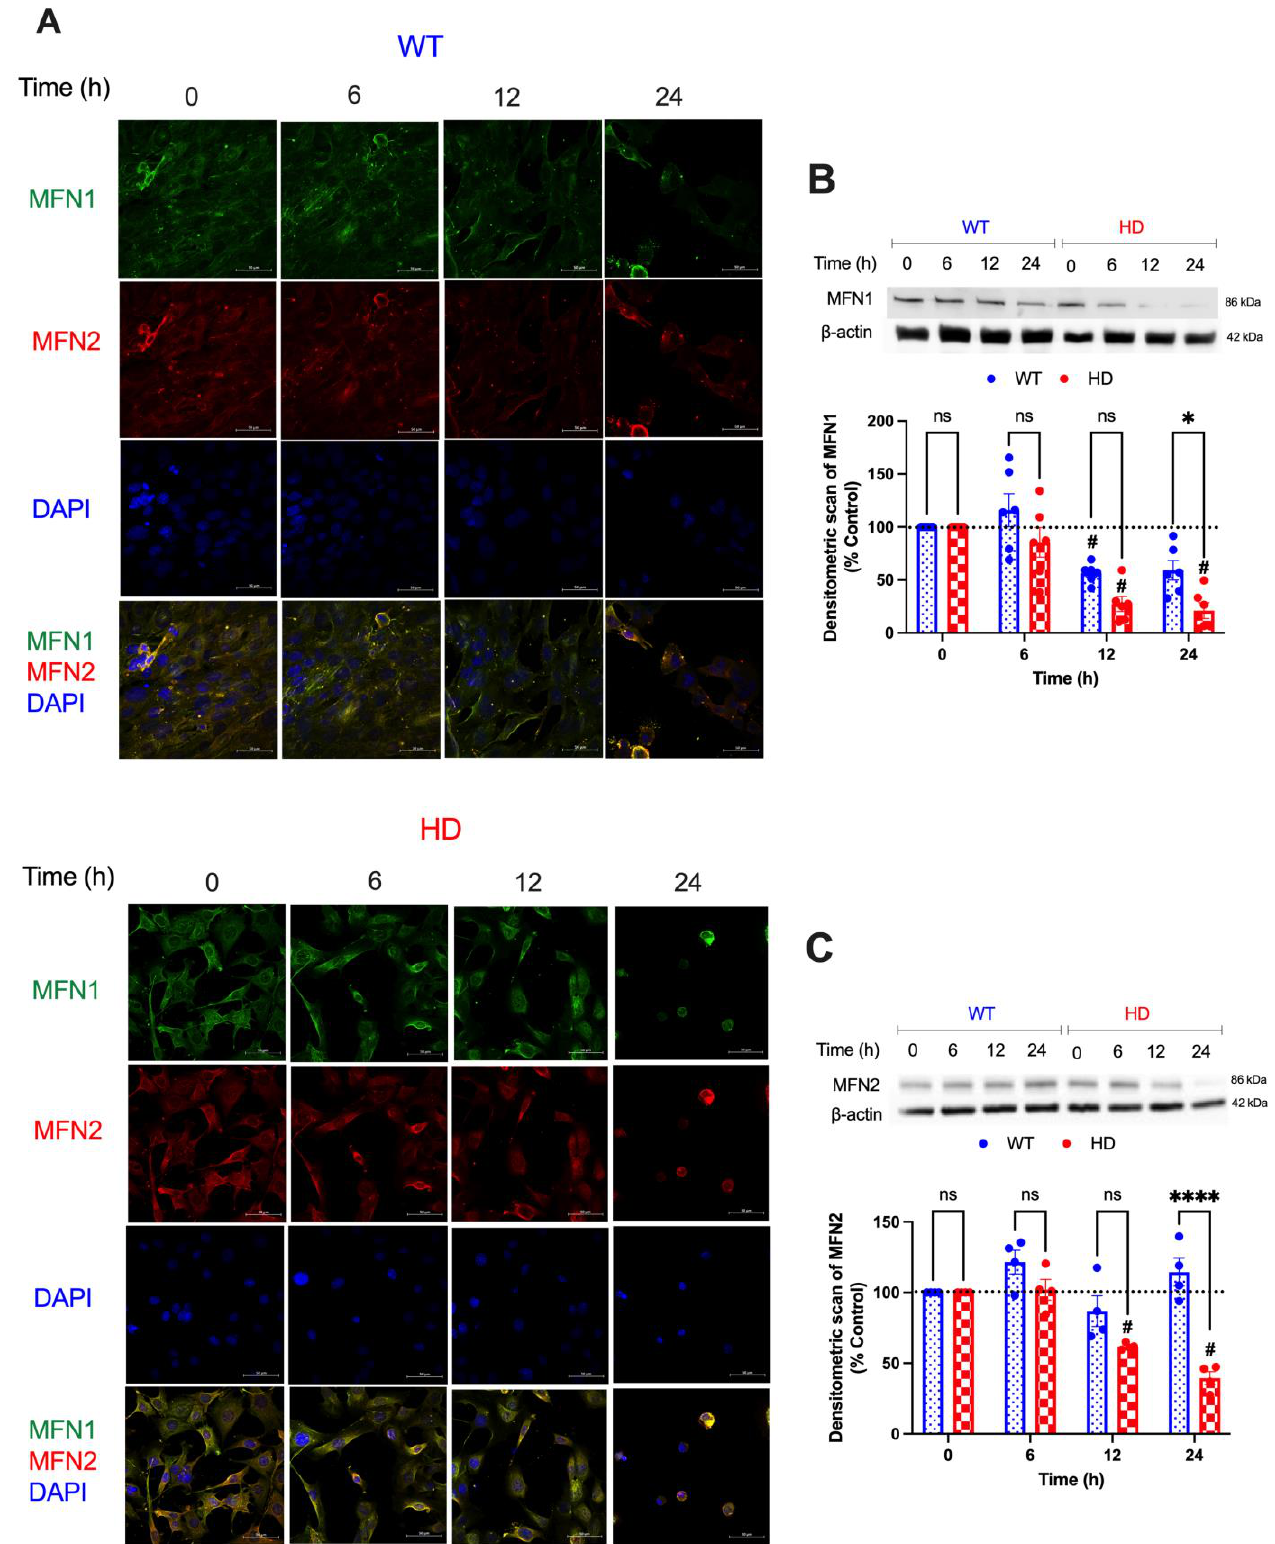
Figure 4. Cd exposure reduces the expression of the pro-fusion mitochondrial protein in HD striatal cells. ( A ) Representative confocal images showing the expression of MFN1 (green) and MFN2 (red) co-stained with DAPI (blue) following 40 µM CdCl 2 exposure for 0, 6, 12, and 24 h. Scale bar: 50 µm. ( B ) Immunoblotting analysis of MFN1 and ( C ) MFN2 in WT and HD striatal cells exposed to 40 µM Cd for the indicated time points. Quantitative immunoblotting data is represented as percent ex- pression relative to the respective control within each genotype. Representative images of Western